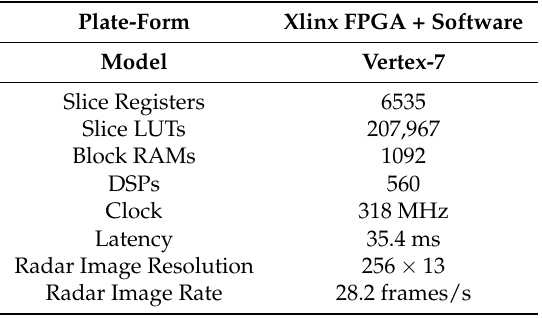
Table 1. FPGA Implementation